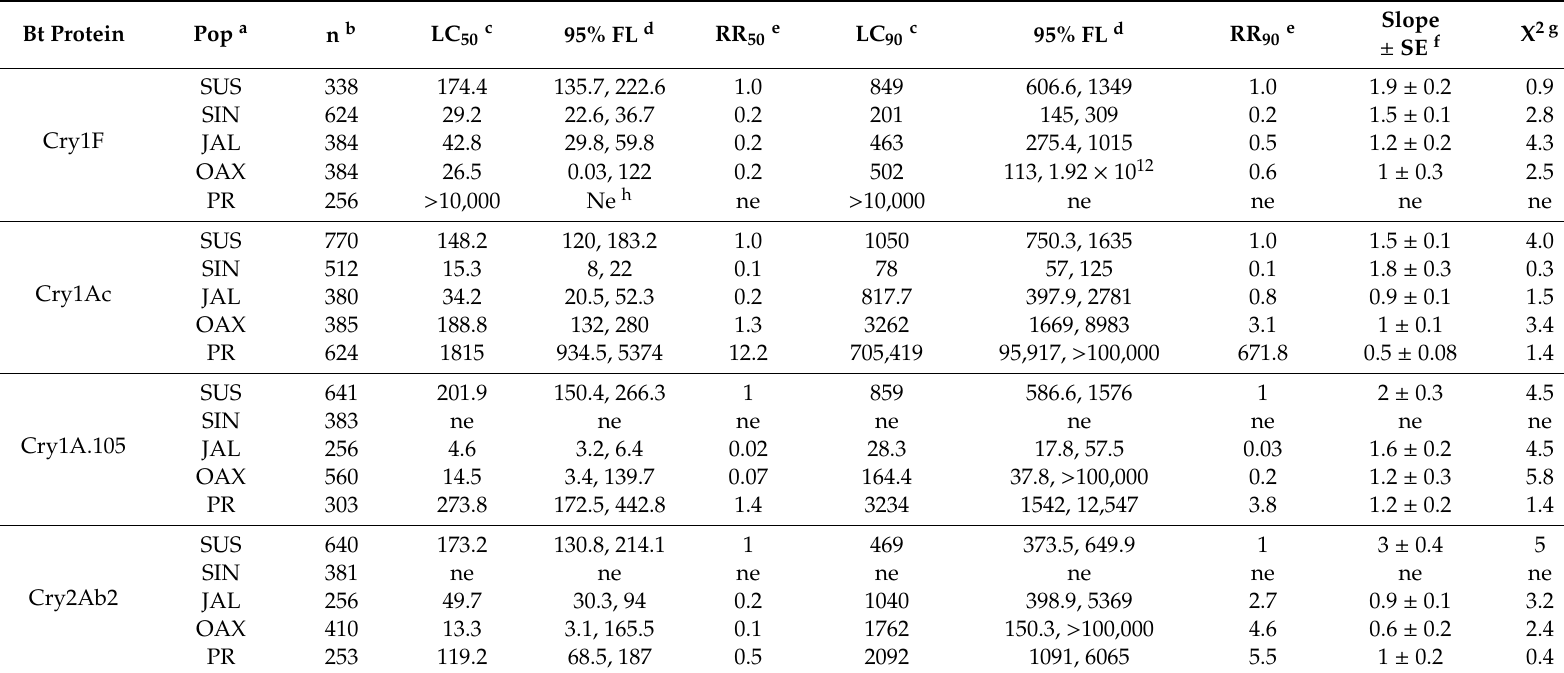
Table 2. Concentration–mortality response (ng / cm 2 ) of fall armyworm from several Mexican states and Puerto Rico to Bt